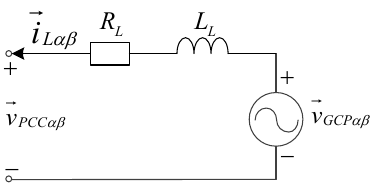
Figure 6. Equivalent circuit of the power system transmission